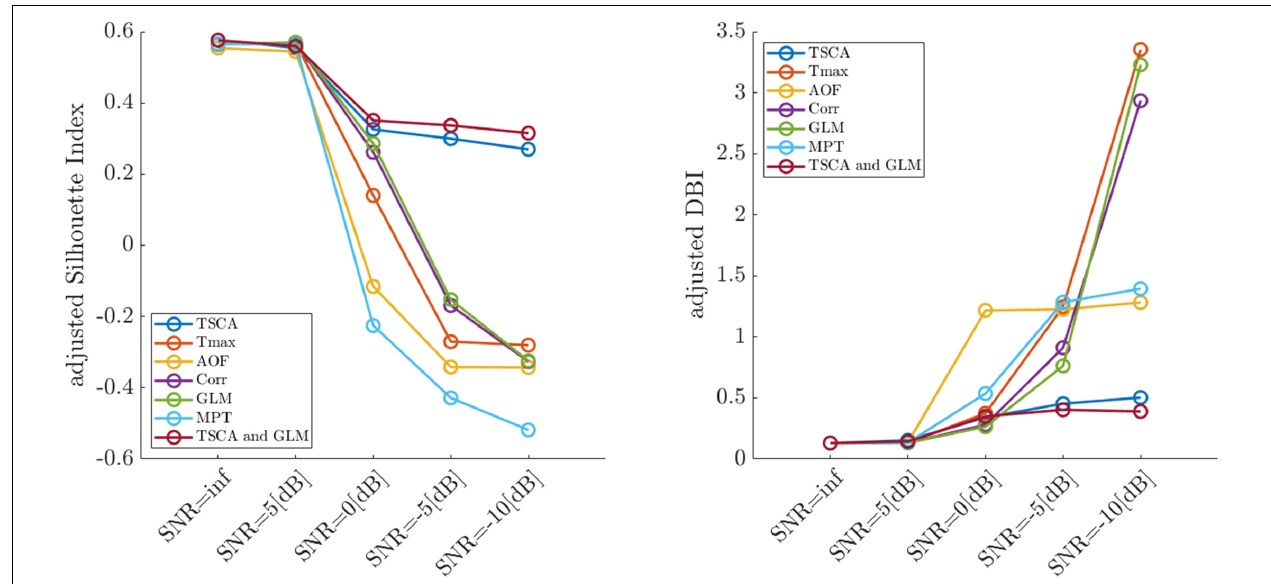
FIGURE 4 | Average values of the adjusted Silhouette Index (left) and the adjusted DBI (right) of retinotopic maps generated by the seven analysis methods for simulated cortical responses with decreasing signal-to-noise ratios. TABLE 1 | Computation times of the seven analysis methods for a single repetition of simulation.